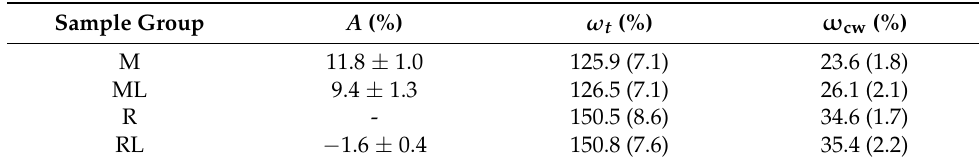
Table 1. Relative mass gain ( A ), moisture content ( ω t ) determined gravimetrically and maximum moisture content of cell wall ( ω cw ) calculated based on the LFNMR results of Scots pine sapwood modified (M), modified and leached (ML), untreated (R) and untreated and leached (RL) at the water-saturated state. Values in parentheses are standard deviation.